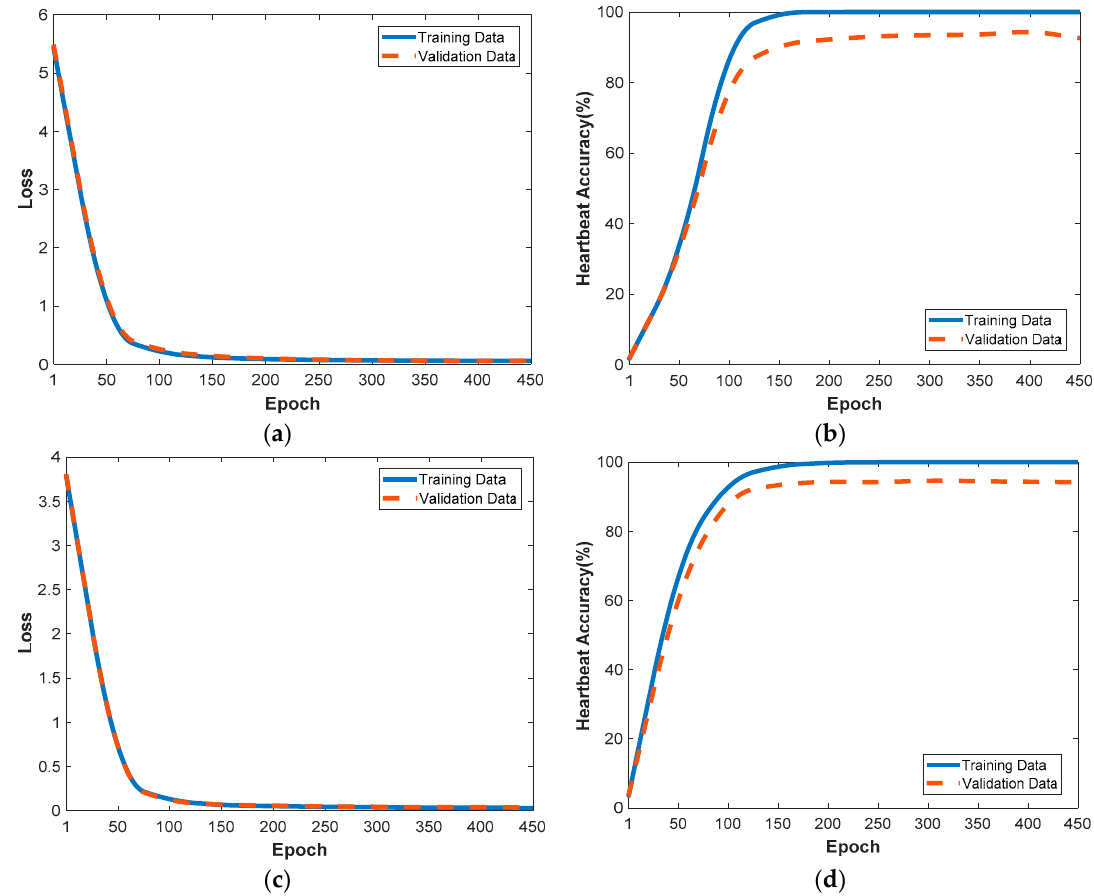
Figure 7. Training and validation process of the S-AEs. ( a ) Train loss of the ECG-ID (Two-recording); ( b ) Train accuracy of the ECG-ID (Two-recording); ( c ) Train loss of the MIT-BIH-AHA; ( d ) Train accuracy of the